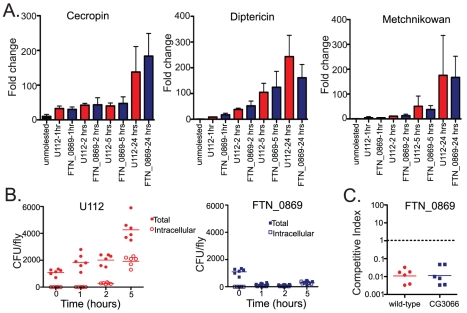
The clearance of extracellular FTN_0869 mutant is not due to altered imd pathway activation, antimicrobial peptide induction, or the Drosophila melanization response.(A) Antimicrobial peptide RNA levels for Cecropin, Diptericin, and Metchnikowan as determined by quantitative RT-PCR. Error bars represent standard error. Antimicrobial peptide induction is not significantly different between wild-type and FTN_0869 mutant F. novicida infections for any of the AMPs tested at any timepoint. (B) Gentamycin chase experiments for early time points, before the induction of antimicrobial peptides. The kinetics of the clearance of extracellular FTN_0869 mutant bacteria are too rapid to be attributed to antimicrobial peptide induction. At one hour post infection, clearance of FTN_0869 mutants has already begun. While only 2.8% of U112 CFUs are intracellular at 1 hour, 29% of FTN_0869 mutant bacteria is already intracellular presumably because the total number of CFUs present in the fly has reduced from 104 per fly to 2*103 per fly. By two and five hours post-infection at 29°C wild-type bacteria have both extracellular and intracellular populations and have begun to replicate. At 2 hours post infection, the total CFU's of U112 per fly has doubled from 1*104 to 2*104 with 14% of the CFUs intracellular. At 5 hours post-infection, the mean total CFUs per fly is 4*104 with 45% intracellular at 5 hours. In contrast, at 2 hours post infection, 27.6% of the FTN_0869 mutant bacteria are intracellular and the total CFUs per fly remains steady at 103/fly. At 5 hours post infection the bacterial levels have increased slightly to 3*103/fly but the intracellular population has increased to 80% of the total CFUs/fly. Horizontal lines indicate the mean. (C) Competitive indexes of FTN_0869 mutants in wild-type w1118 flies and in non-melanizing CG3066 mutant flies two days post-infection at 29°C. There is no statistically significant difference between the competitive indices in wild-type and non-melanizing flies, with a P value of 0.601 by 2-tailed t-test, showing that the FTN_0869 mutants are not rescued in Drosophila melanization mutants. Horizontal lines represent the geometric mean of each data set.